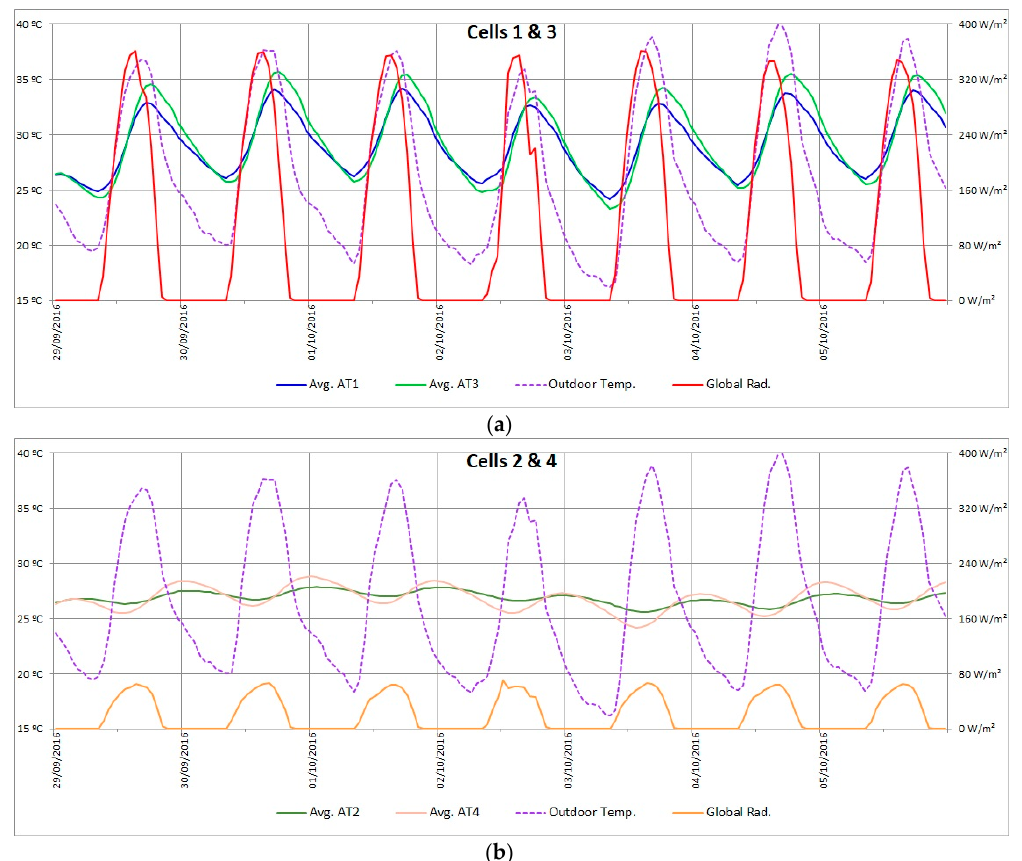
Figure 7. Air ambient temperature and global solar radiation in one week. Free-running: ( a ) Cells 1 and 3 (south) and ( b ) Cells 2 and 4 (north). Table 9. Air ambient temperature in Cells 1 and 3 .